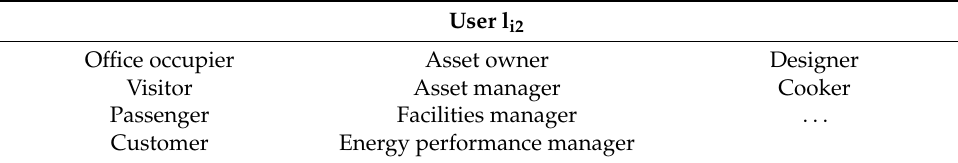
Table 3. Asset Omni-management model—Users.